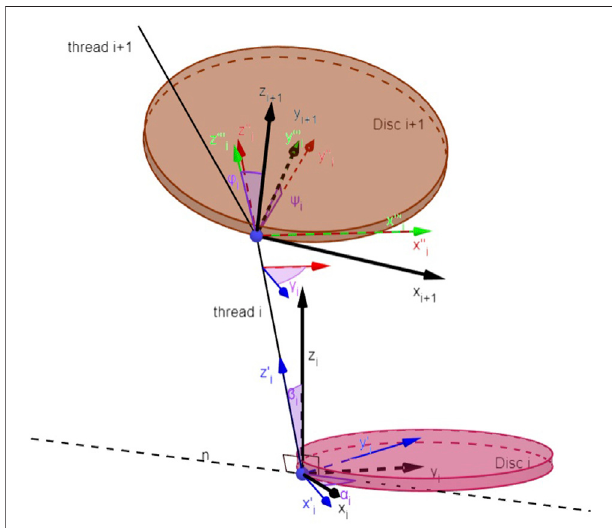
FIGURE 2 | Disc-thread model [Reprinted from (Bui and Schultz, 2021) with permissions].